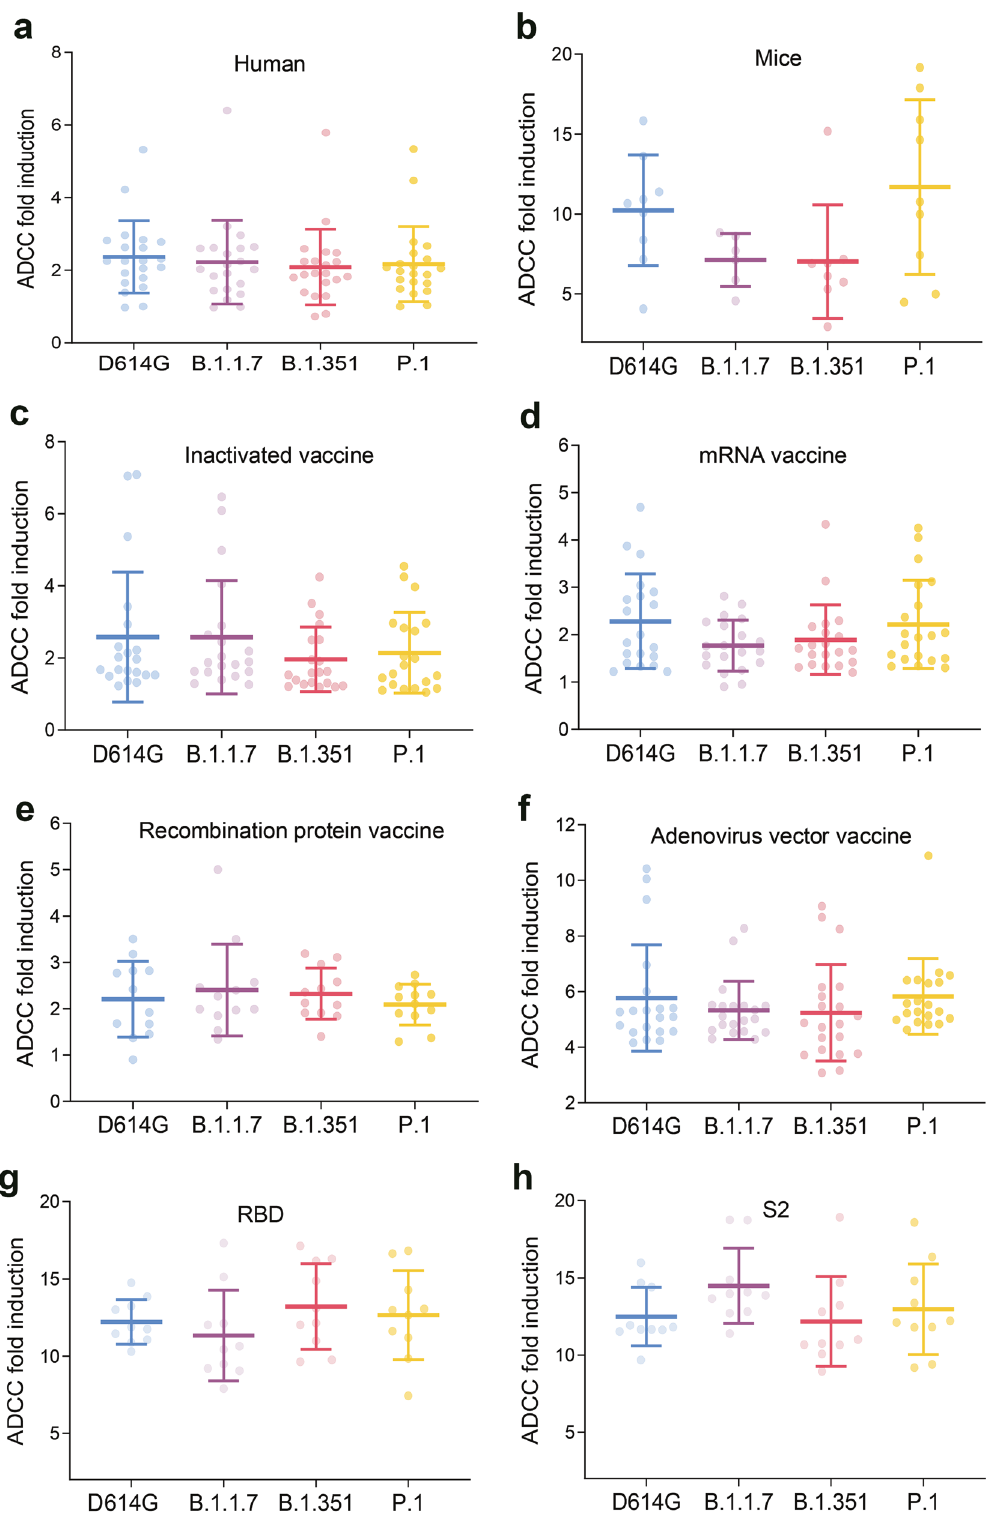
speci fi c pathogen-free BALB/c mice with puri fi ed proteins (ACROBiosystems, China). The corresponding protein (20 μ g) was mixed with an equal amount of aluminum adjuvant. For each protein, ten mice were subcutaneously immunized every other week. Immunized mouse sera were collected from